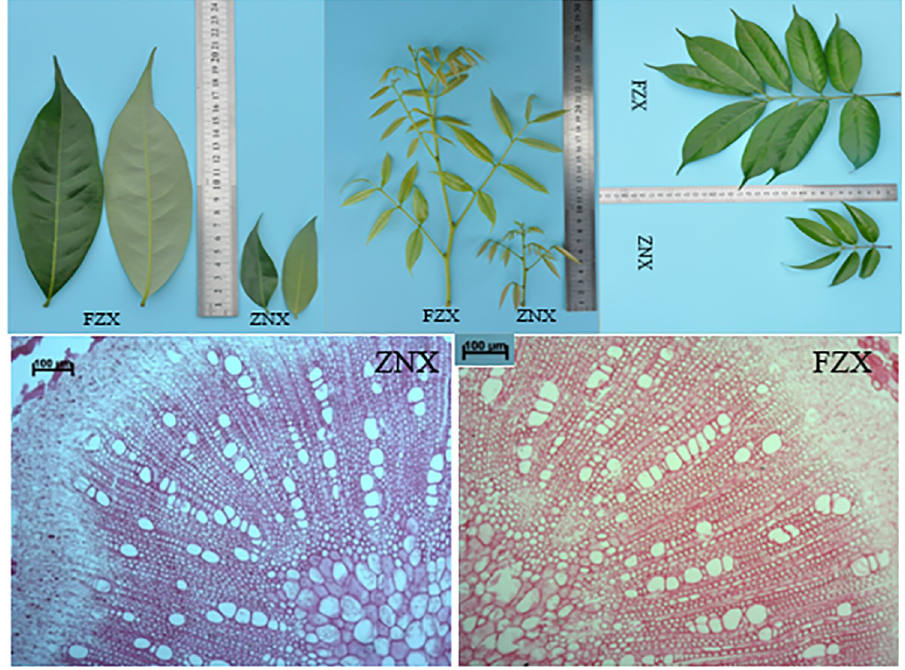
Fig 1. The comparison of leaf, compound leaf, terminal bud (upper) and compound leaf petiole longitudinal sections (lower) between FZX and ZNX litchi cultivars.